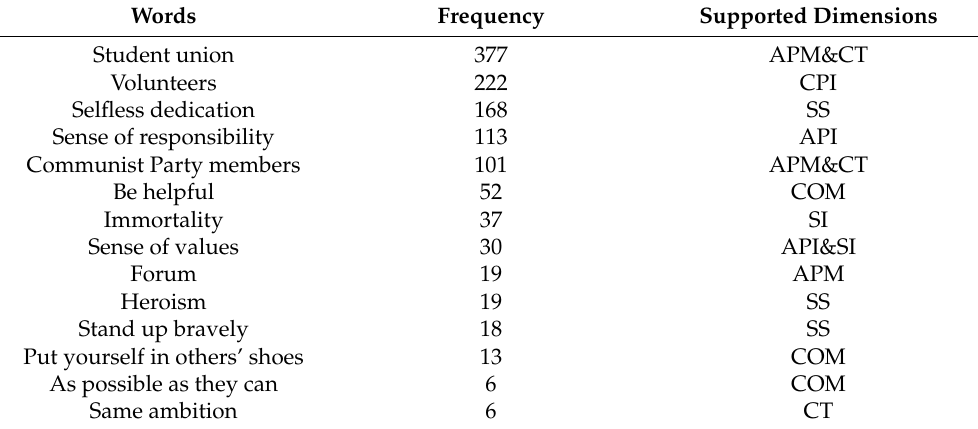
Table 8. Word frequency statistics.